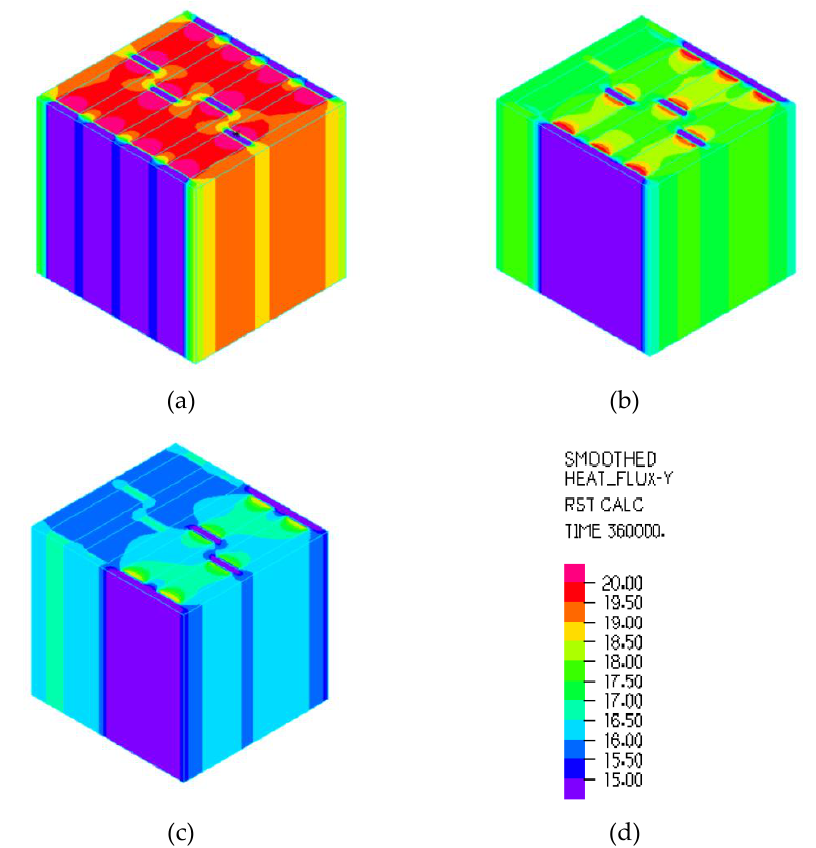
Figure 8. Density of the heat flow flowing through the component for the assumed emission factor = 0.85. ( a ) variant 1, ( b ) variant 2, ( c ) variant 3, and ( d ) range of results in graphic form.